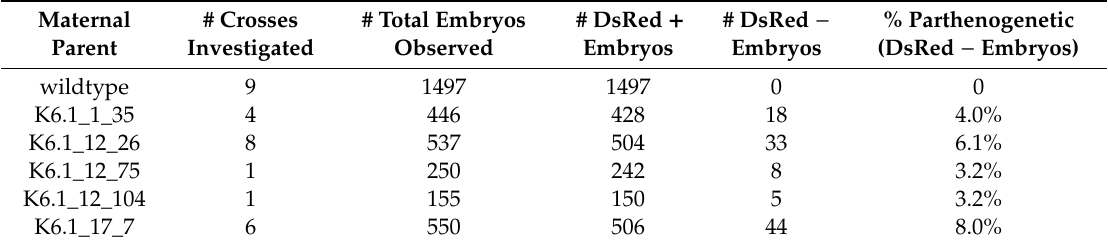
Table 4. Expression of DsRed in developing embryos of the crosses between 4 x T2 plants of line